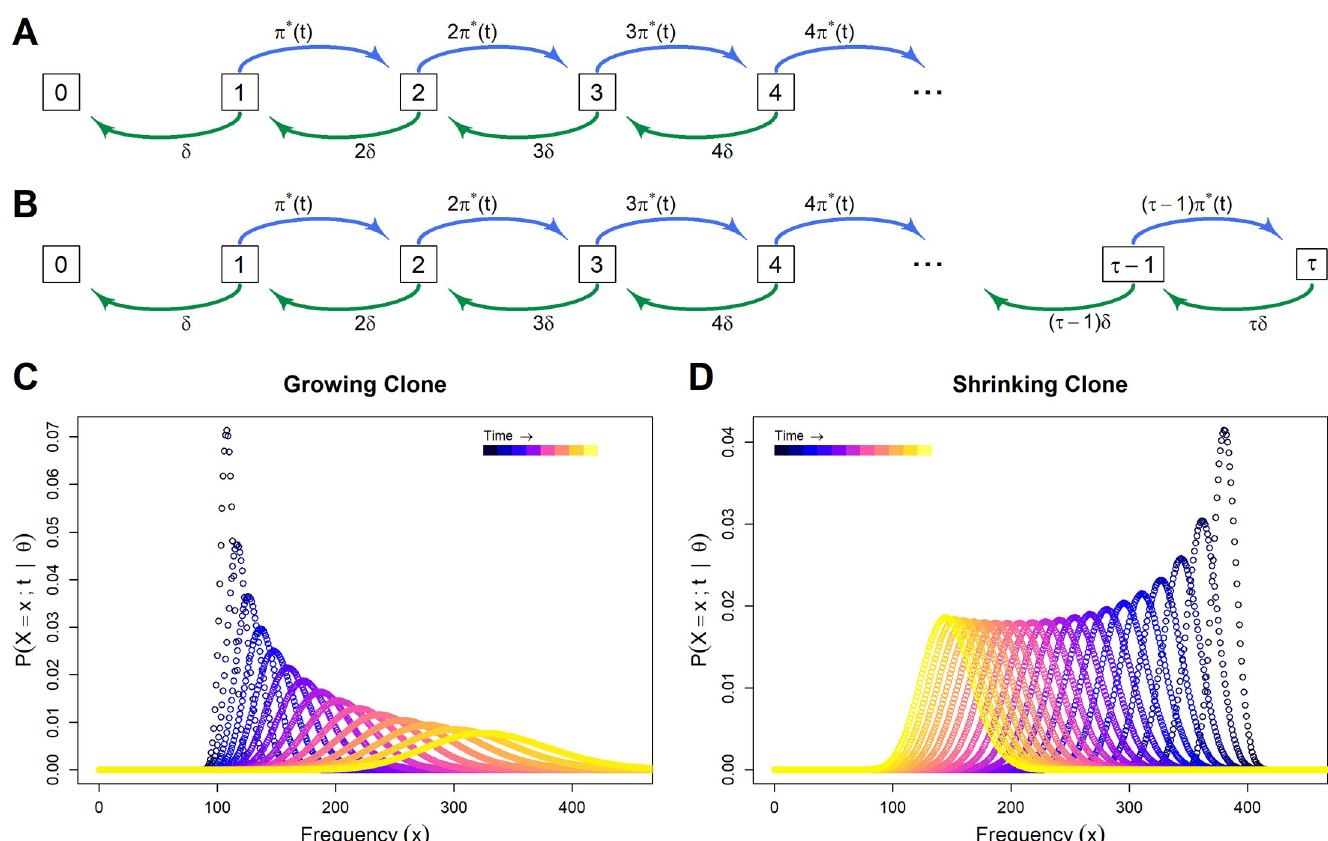
Fig 3. Stochastic clone dynamics. A and B respectively show the clone state space with and without an upper limit τ . Each box denotes the potential state of a given clone, i.e. the number of cells in that clone, with the corresponding propensity of each reaction at each state. π � (t) and δ denote the per-capita rates of infected cell proliferation and death respectively. Note there is no source inflow from frequency 0 to frequency 1 . C and D show clone frequency probability distributions over time. Each curve shows the distribution P ð X ; t Þ ¼ P ð X ð t Þ ¼ x j X ð 0 Þ ¼ x Þ of the probability that the given clone i contains x i cells at time t. At successive time i i i i i ; 0 points the curve broadens and either shifts to the right as the expected frequency of the clone increases (C) , or shifts to the left as the expected frequency of the clone decreases ( D)